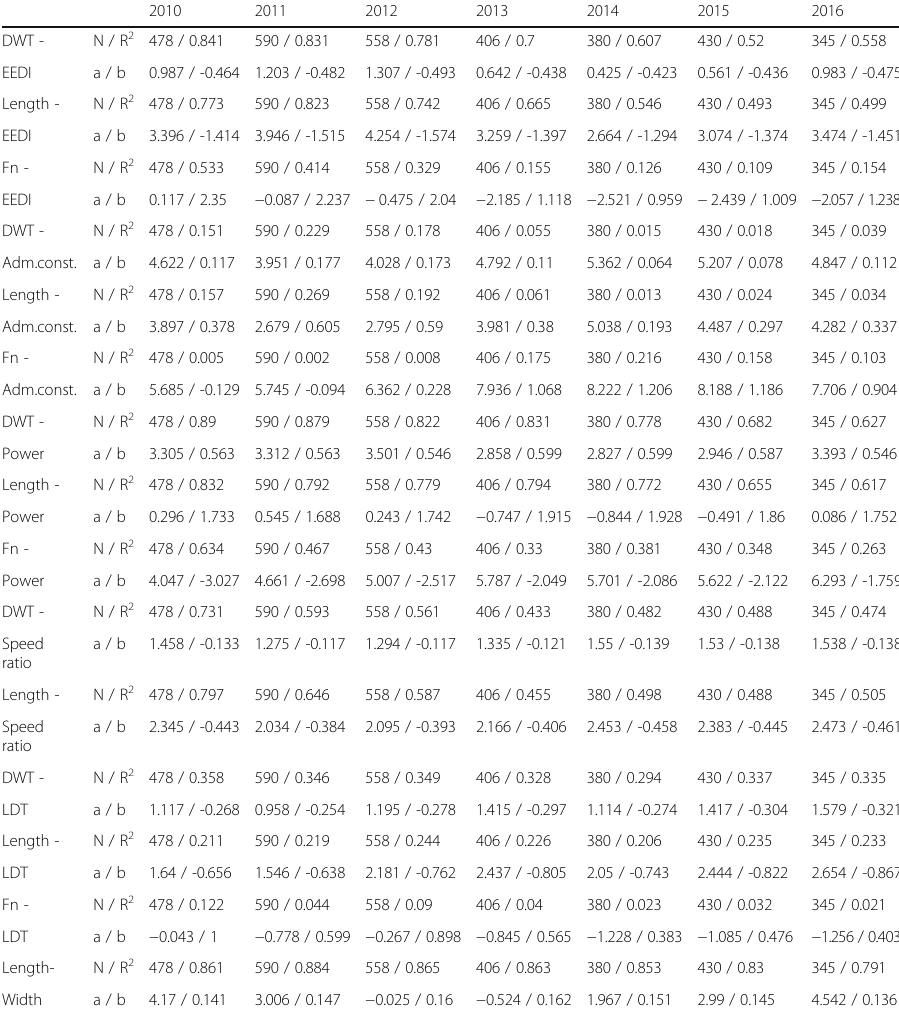
Table 4 Estimation results for all